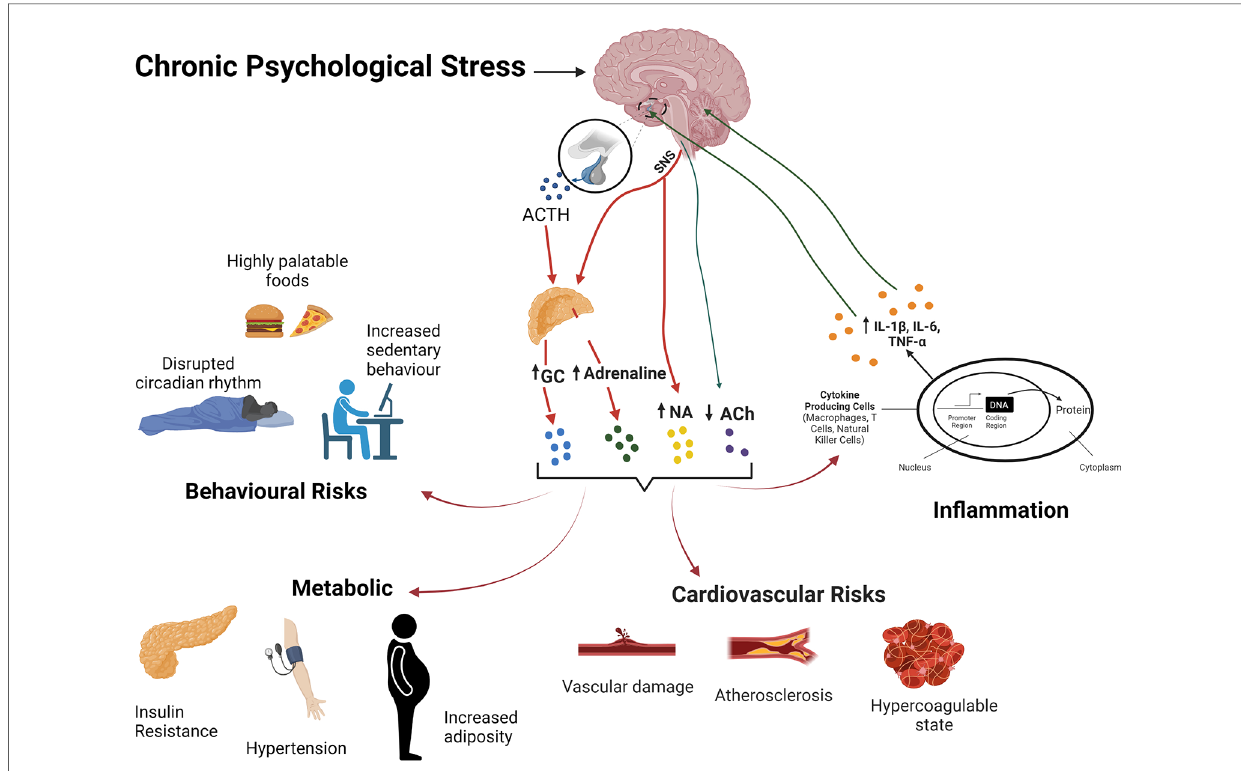
FIGURE 2 The stress response and its effects on body systems and CVD risk. Chronic stress activation of the HPA axis and SNS activity result in elevations in glvuocorticoids (GC) and catecholamines, and reduced PNS activity. Resultant behavoural/affective outcomes, immuo-in fl ammatory dysregulation, metabolic and cardiovascular effects collectively favour development of